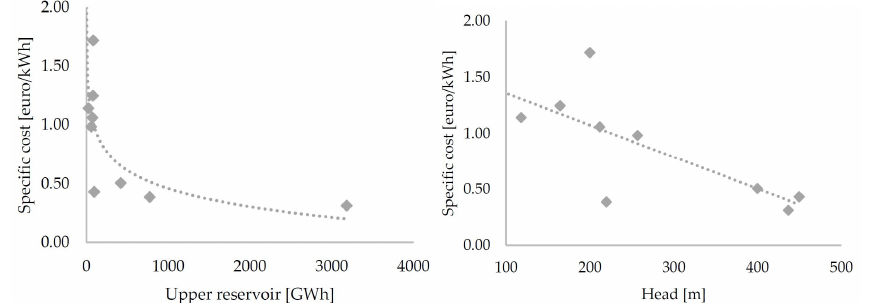
Figure 2. Cost correlation analysis for the Norwegian PSPs.